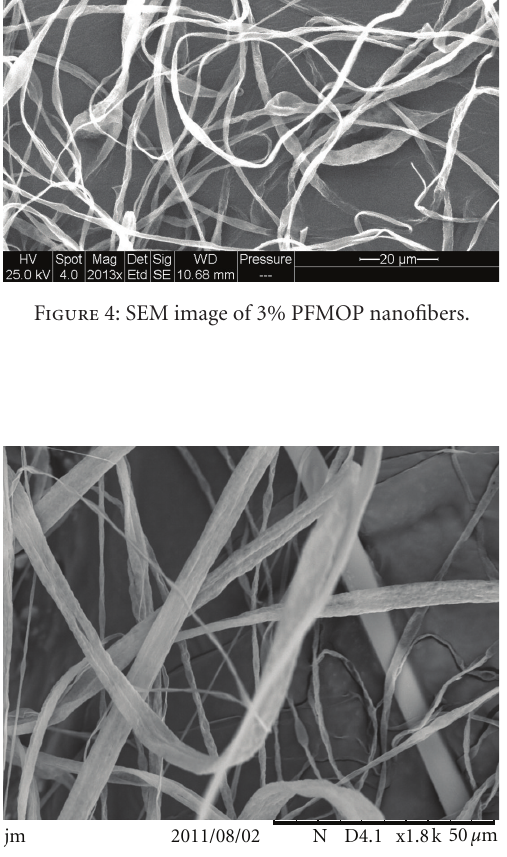
Figure 5: SEM image of 4% PFMOP nanofibers.